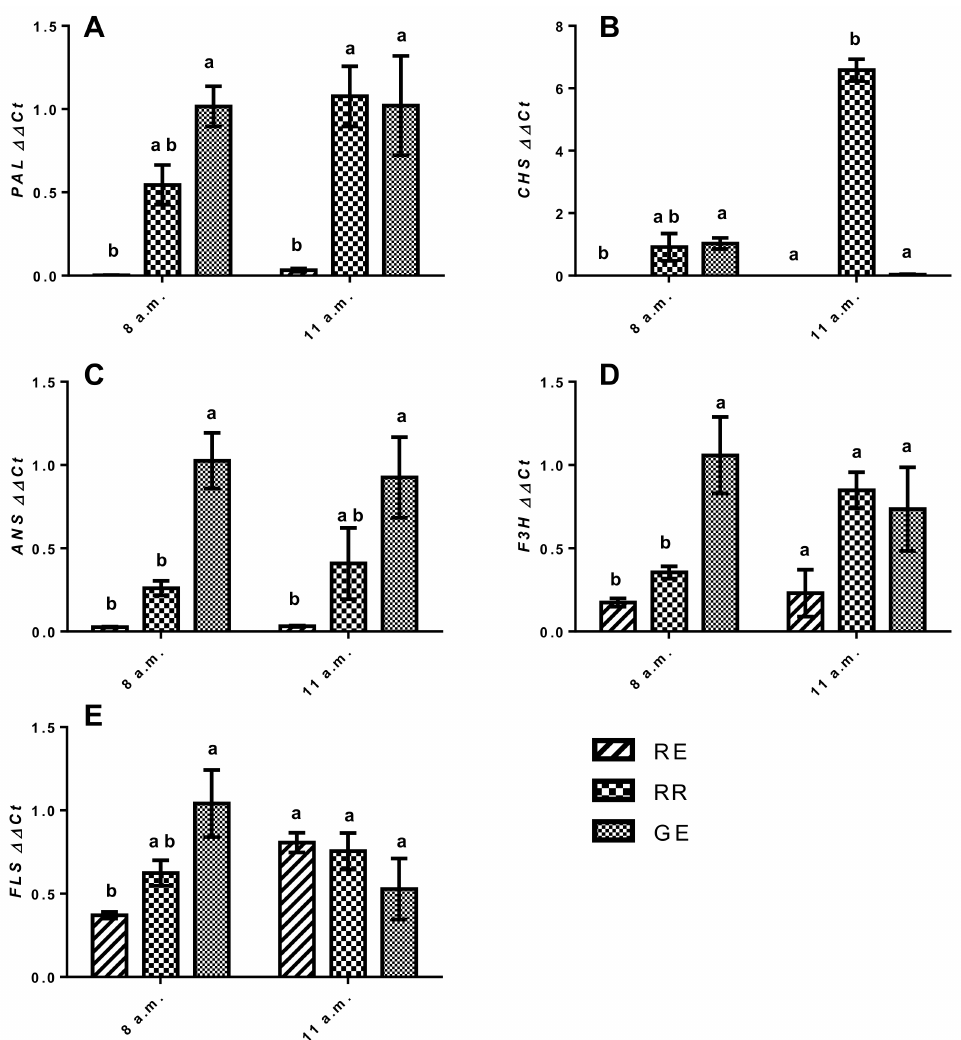
Figure 4. Expression of the key genes in the phenylpropanoid pathway measured at 8 a.m. and 11 a.m. in RE, RR, and GE. Data are means ± SE ( n = 3). Different letters indicate significant differences among the varieties within a time